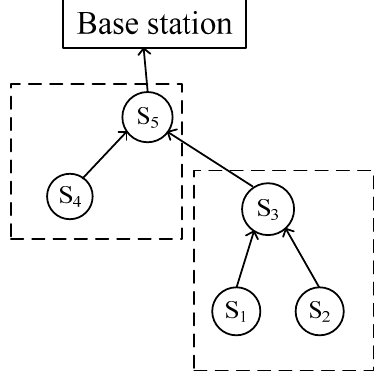
Figure 2. Diagram of the node domination relationship.